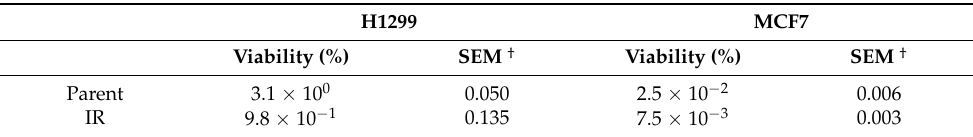
Table 1. Radio-sensitivity of Parental cells and IR cells in H1299 and MCF7.